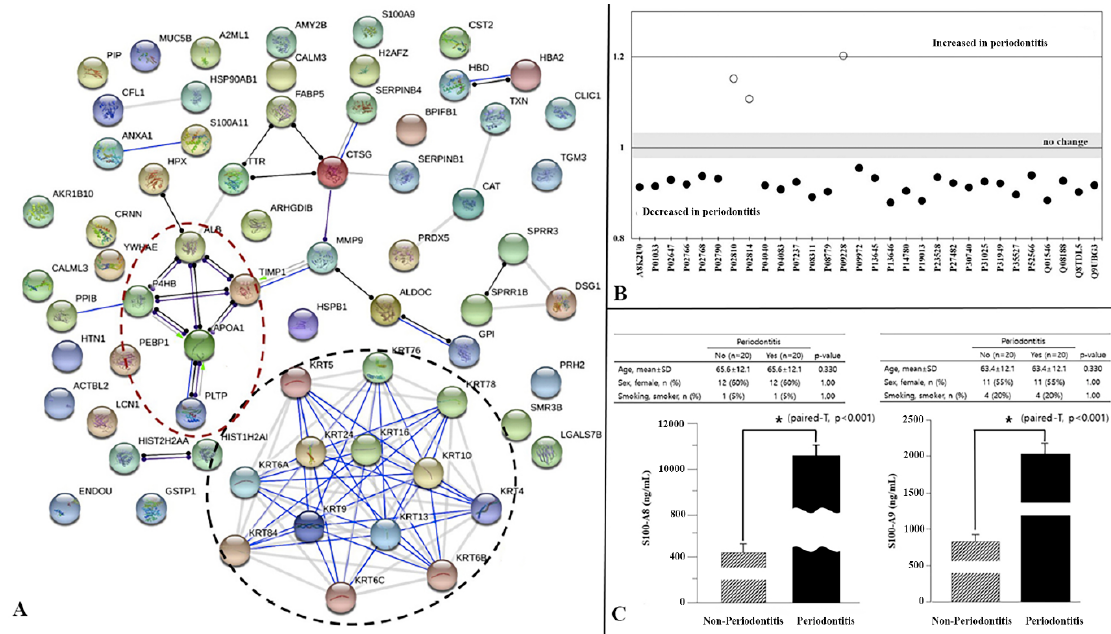
Figure 3. ( A ) Hartenbach et al. reported the protein–protein interaction network analysis of all salivary proteins involved in health and diseases state of periodontium. Black lines depict that one protein reacts non-specifically with another. Blue lines indicate there is binding among them. The purple lines mean catalysis. ( B ) The salivary protein difference between periodontal health and chronic periodontitis [116] ( C ) Shin et al. studied S100A8 and S100A9 using ELISA as potential candidate biomarkers [117]. The images are adapted with permission from the publisher.